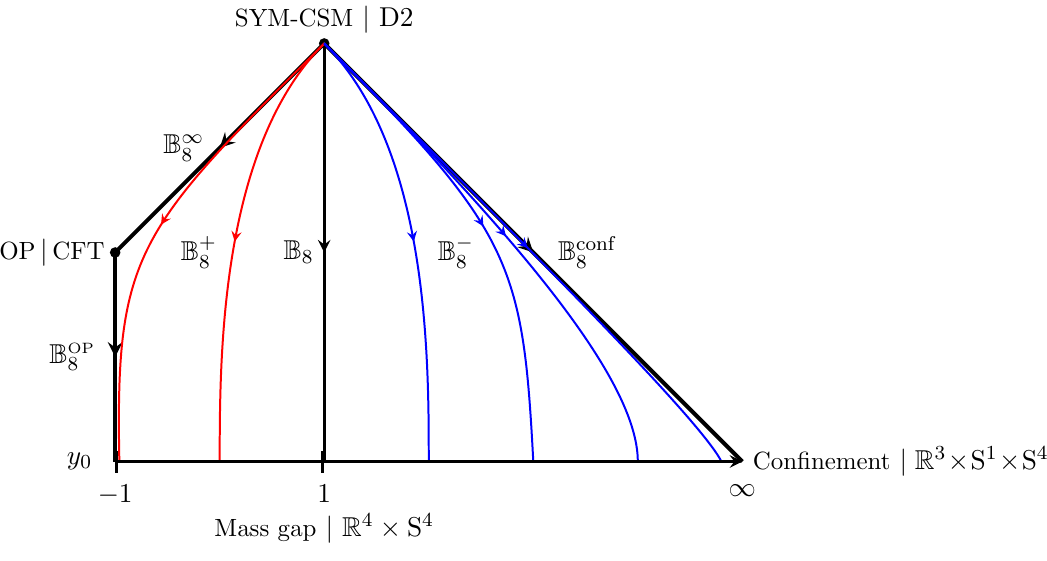
Figure 3 . Pictorial representation of the di(cid:11)erent solutions (see main